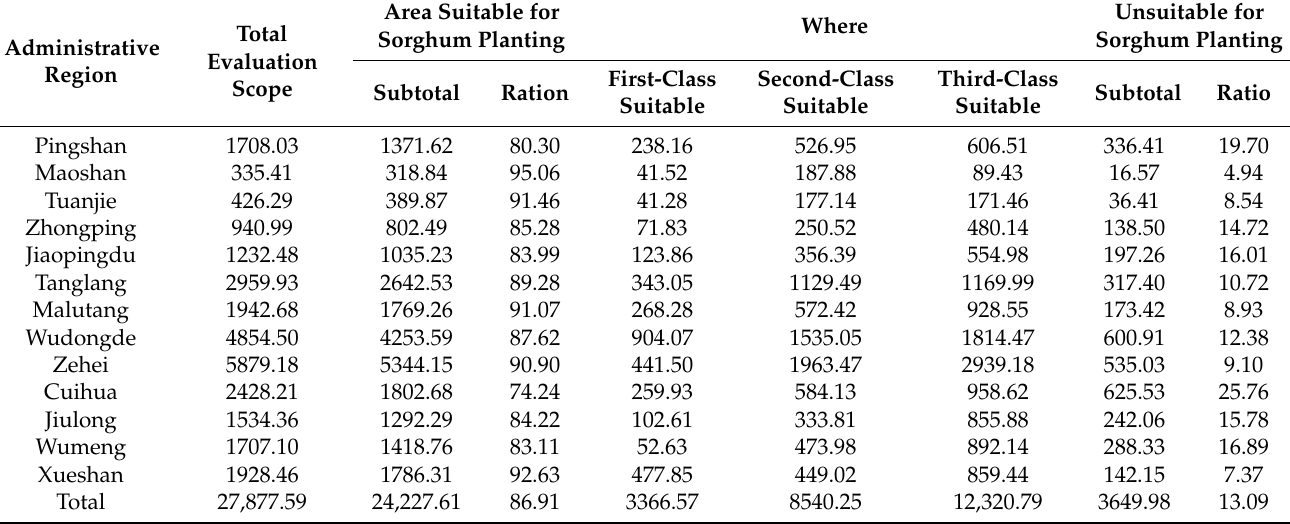
Table 8. Area of land suitability grade of sorghum planting in Jinsha River Basin of Luquan County (Unit: ha,